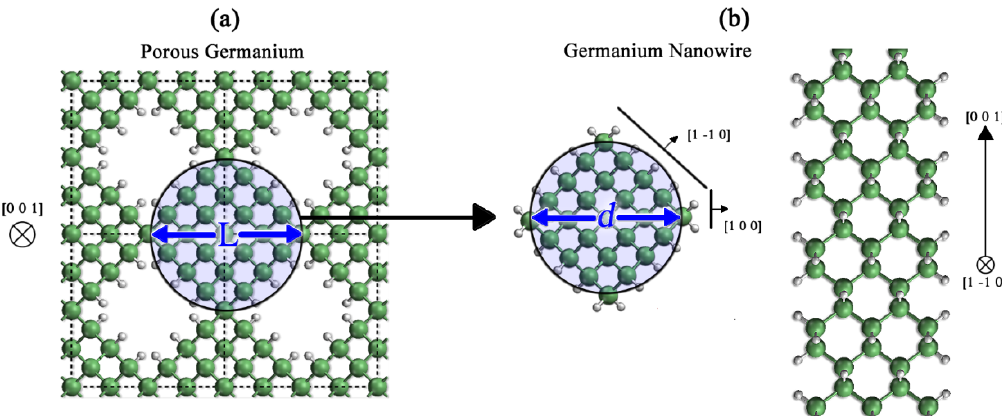
Figure 1. Models of Ge nanostructures. ( a ) Top view of an 8-atom supercell of pGe with p = 12.5%, where the circle shows the confined area; ( b ) top and side views of a GeNW grown in the [001] direction. The green and grey spheres represent Ge and H atoms,